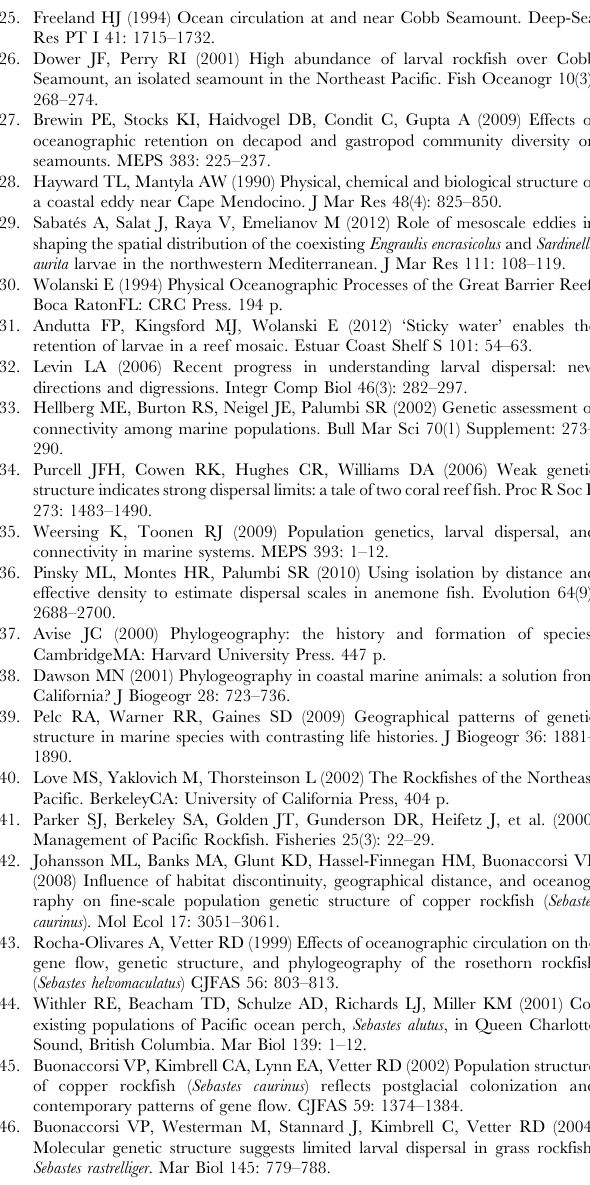
Table S4. ‘‘Old’’ pairwise F ST values. Pairwise F ST values for the ‘‘old’’ dataset are shown below. Statistically significant values are shown in bold . Table S5. ‘‘Young’’ pairwise F ST values. Pairwise F ST values for the ‘‘young’’ dataset are shown below. Statistically significant values are shown in bold . Table S6. STRUCTURE mean log likelihood results. Mean log likelihood of each K value (LnP( K )) and standard deviation (S.D.) are shown for both models evaluated in STRUCTURE: an admixture model without a location prior, and an admixture model with a location prior. The most likely value of K is shown in bold under each